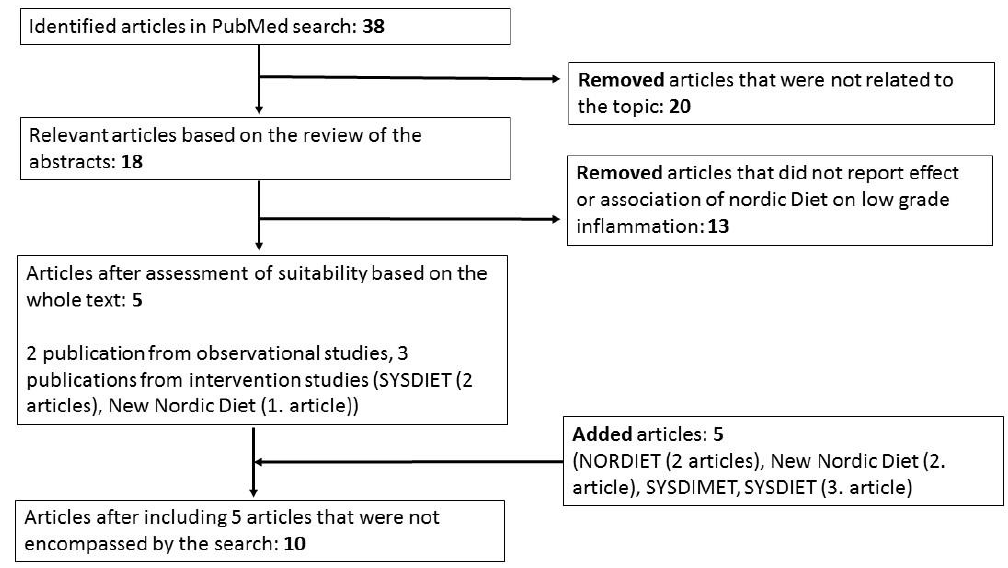
Figure 1. Procedure for selection of articles.